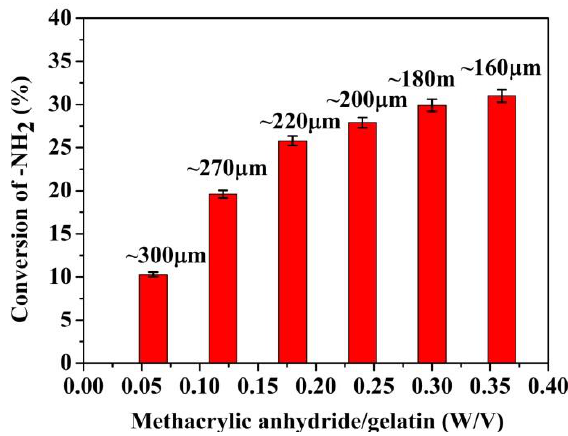
Figure 2. The effect of MAA to gelatin ratio on the pore size. SD 0.3, n = 3.